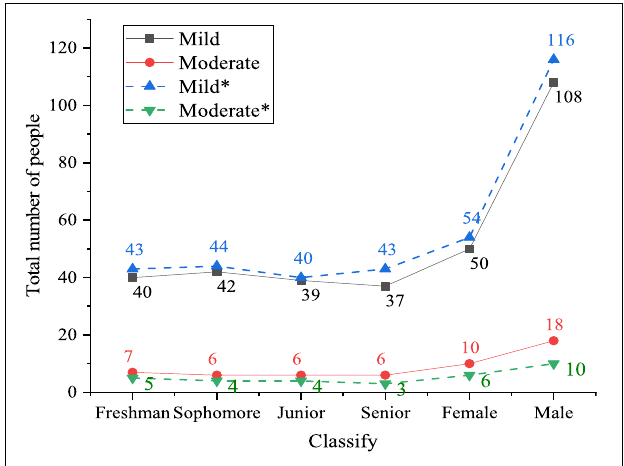
FIGURE 7 | Distribution curve of symptoms of students in sports majors under two kinds of education ways (the curve with an asterisk shows the mental state of college students after receiving big data network mental education).